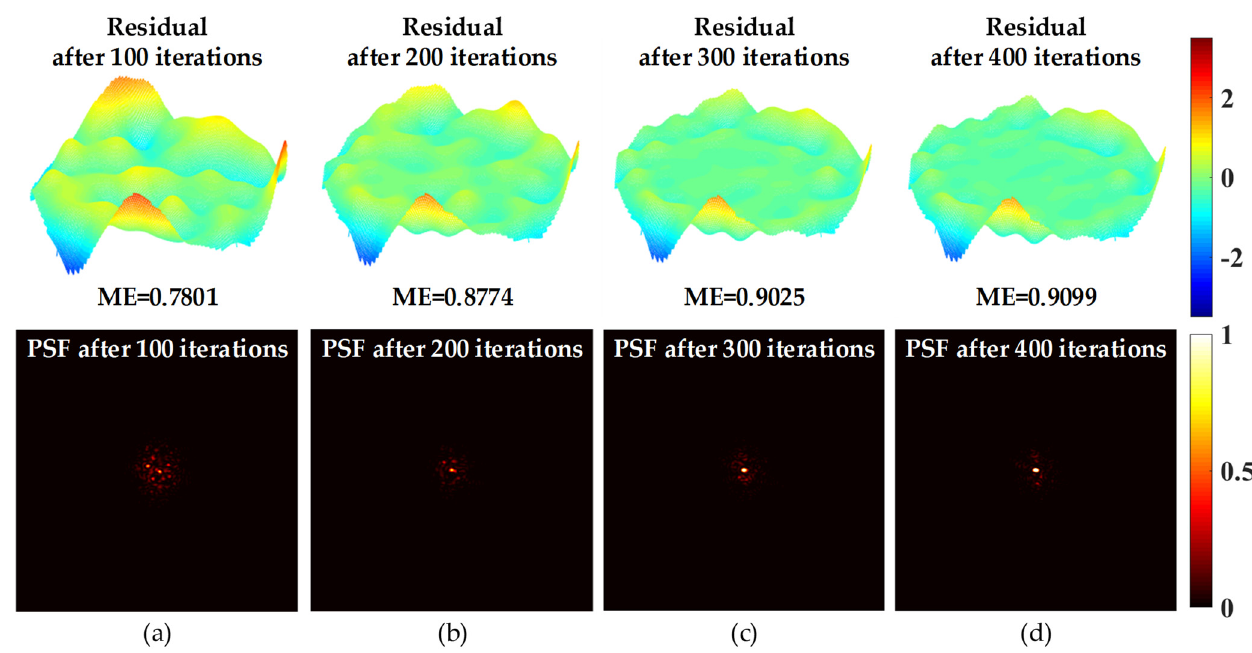
Figure 4. Wavefront correction results under different iterations: ( a ) residual wavefront aberration and the corresponding PSF after 100 iterations; ( b ) residual wavefront aberration and the corre- sponding PSF after 200 iterations; ( c ) residual wavefront aberration and the corresponding PSF after 300 iterations; ( d ) residual wavefront aberration and the corresponding PSF after 400 iterations.